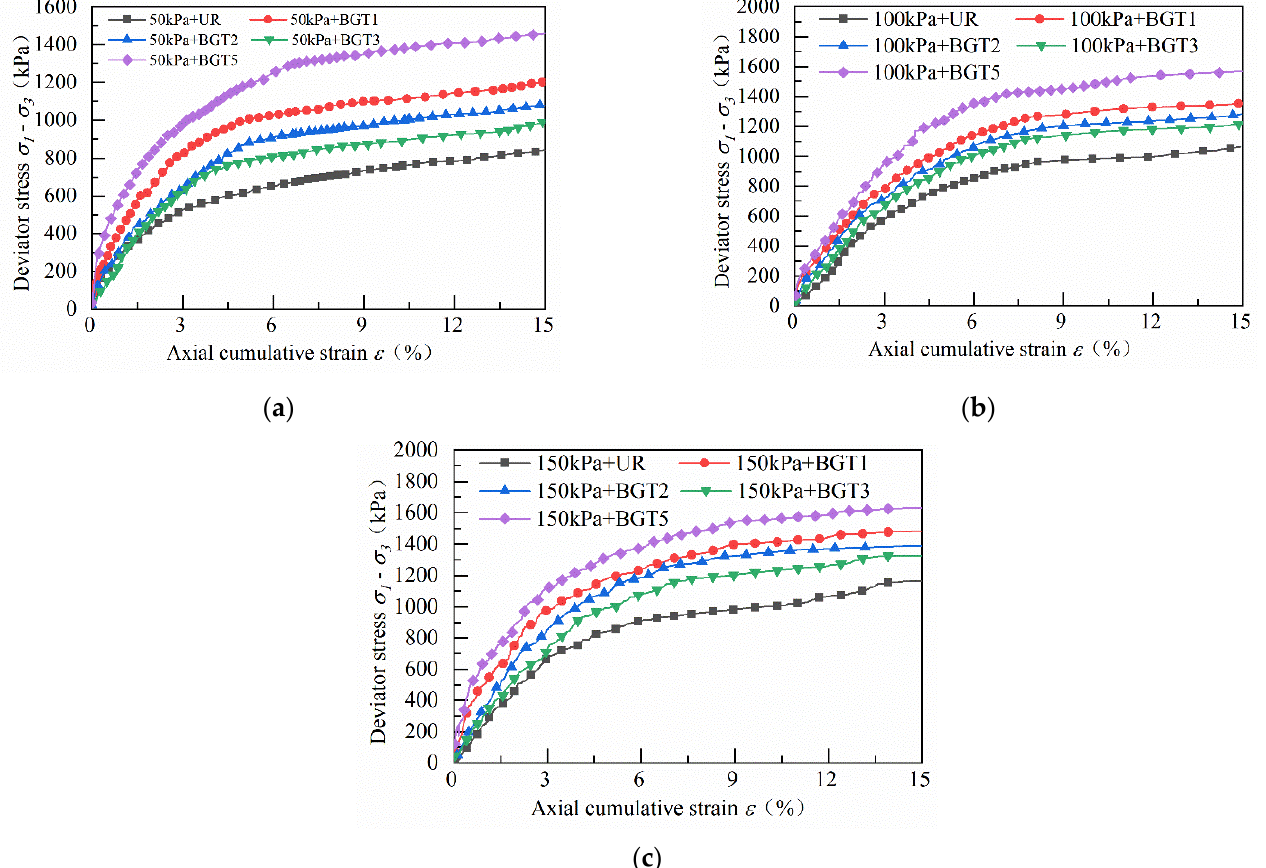
Figure 8. Stress–strain relationship curves for geogrid reinforcement track bed layers at three different confining pressures: ( a ) 50 kPa geogrid reinforcement; ( b ) 100 kPa geogrid reinforcement; ( c ) 150 kPa geogrid reinforcement.